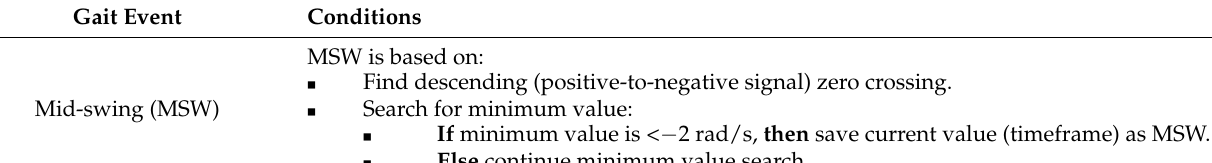
Table 1. Summary of heuristic rules for GED algorithm.